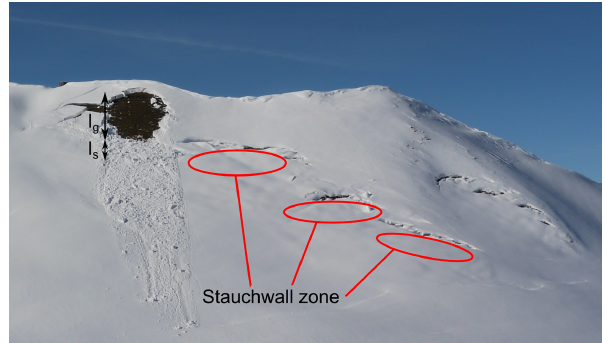
Figure 1. Opening of glide cracks ( Fischmaul ) near Davos. The left slope released, probably because the slope is steeper than the right part. l g and l s denote the observed slab length and the stauchwall